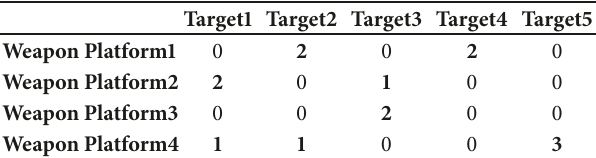
Table 3: The reference solution (assignment